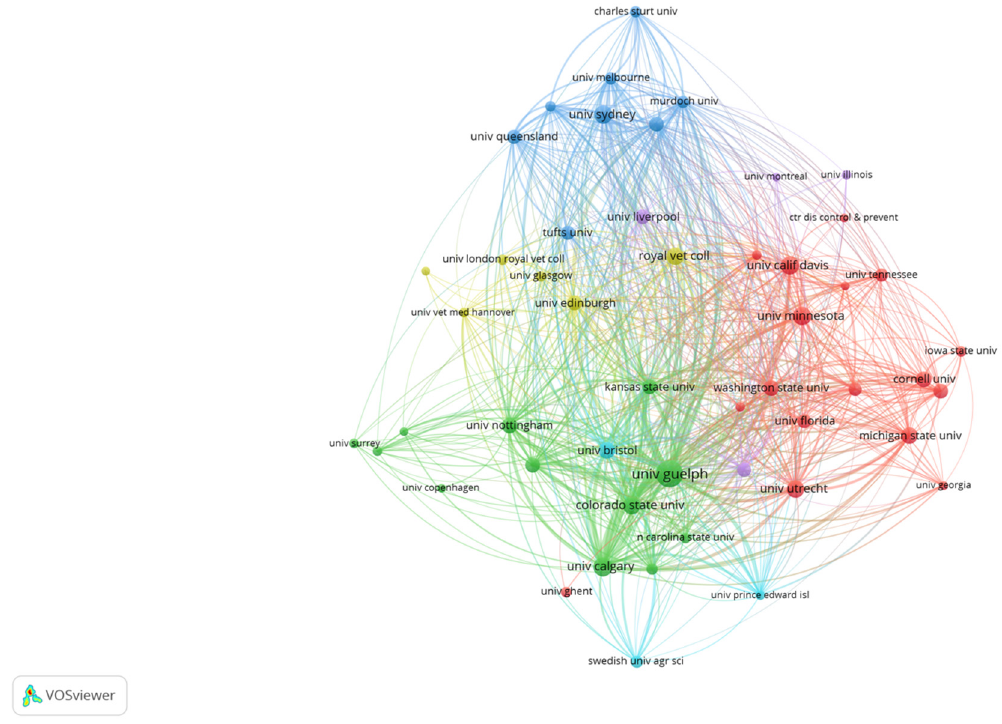
Figure 5. Institutional collaboration analysis of 677 veterinary communication education publications (VCEPs) from 2000 to 2021.